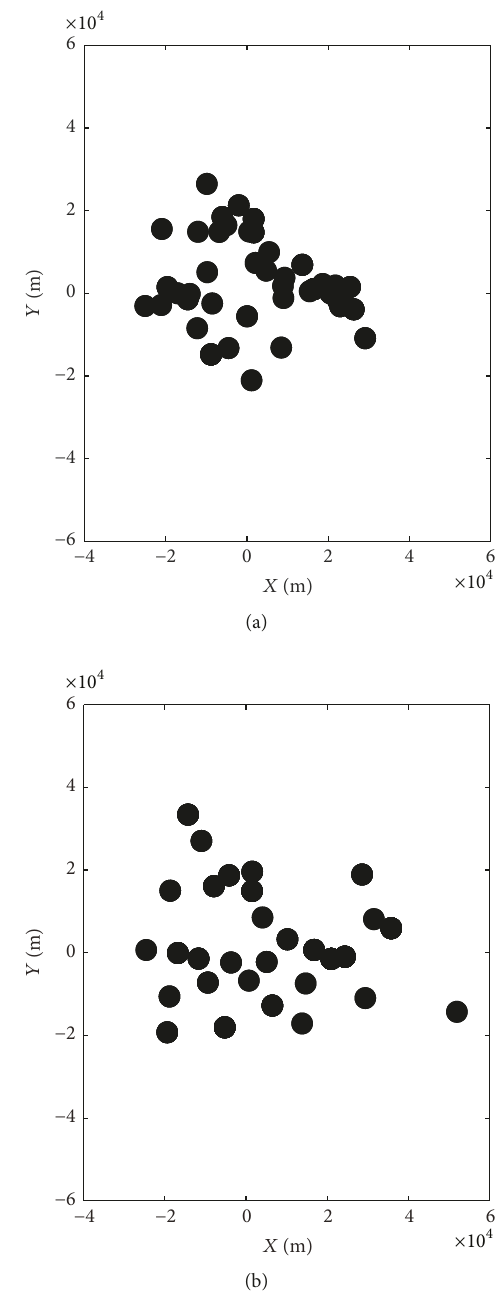
Figure13:ContrastfigureoftheCBoriginalstations’arealcoverage. (a) Current original stations’ areal coverage. (b) The planning original stations’ areal